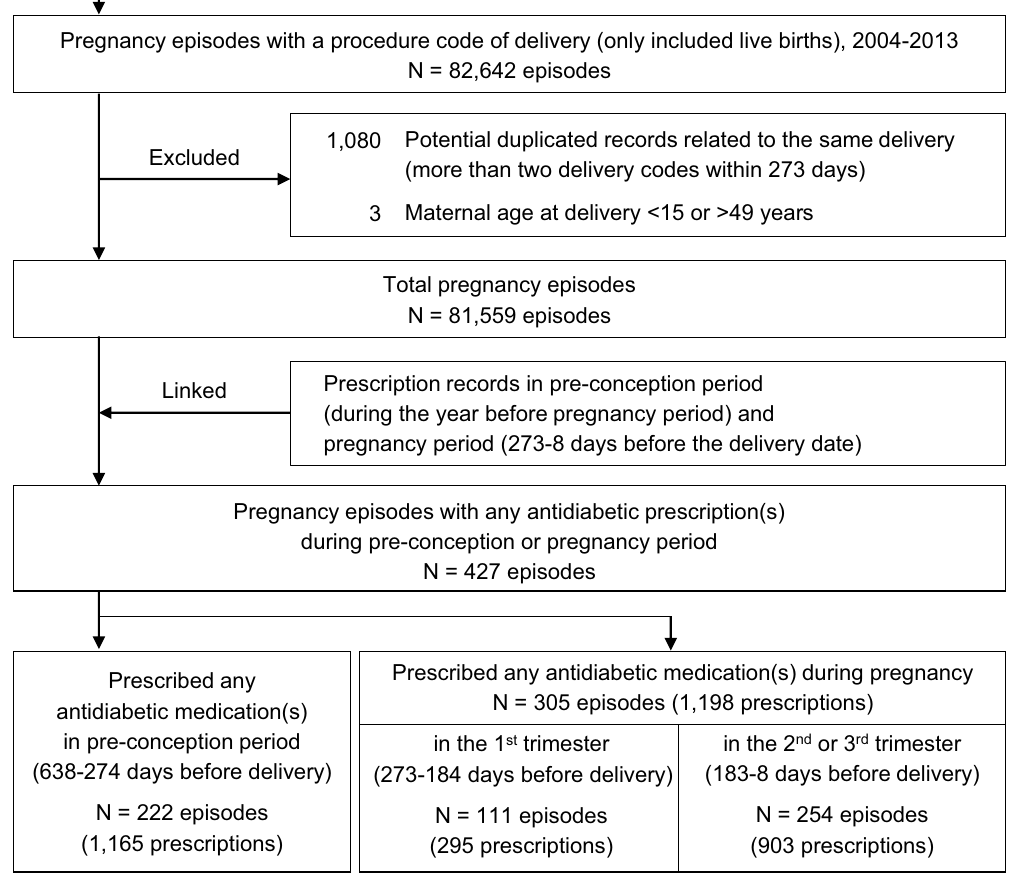
Figure 1. Flow chart for identification of study